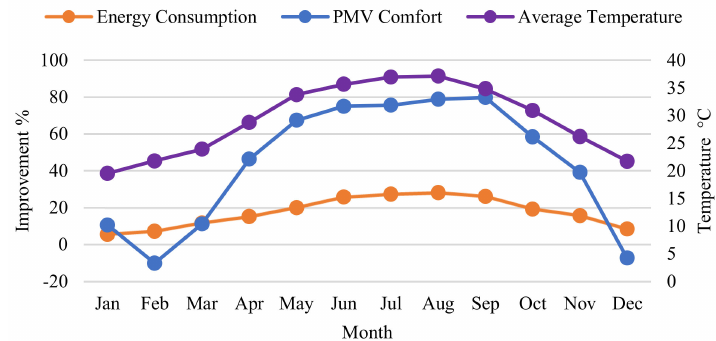
Figure 11. Energy and thermal comfort improvement per month.